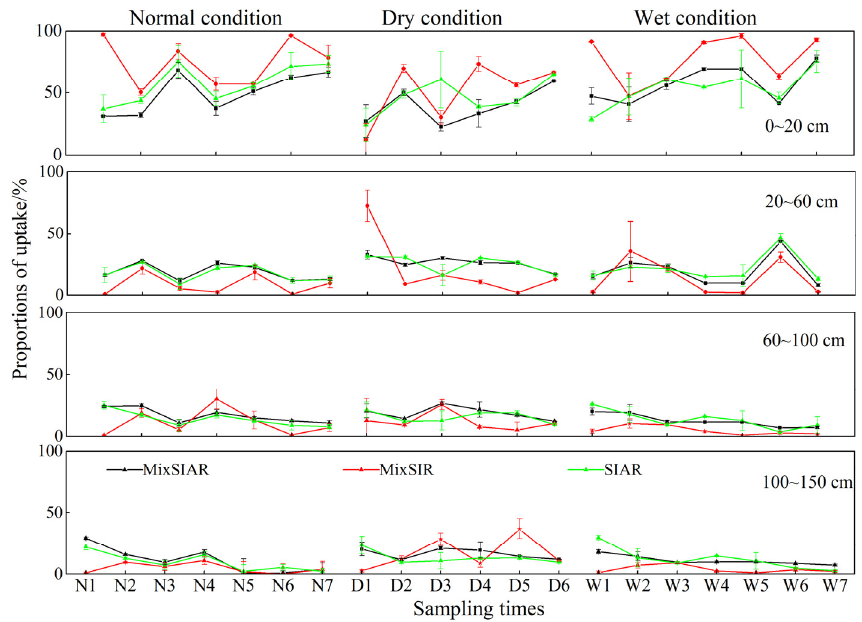
Figure 5. Mean water-absorbing proportional contributions of wheat from each soil depth interval under various SWC conditions using MixSIAR (black line), MixSIR (red line) and SIAR (green line) models.